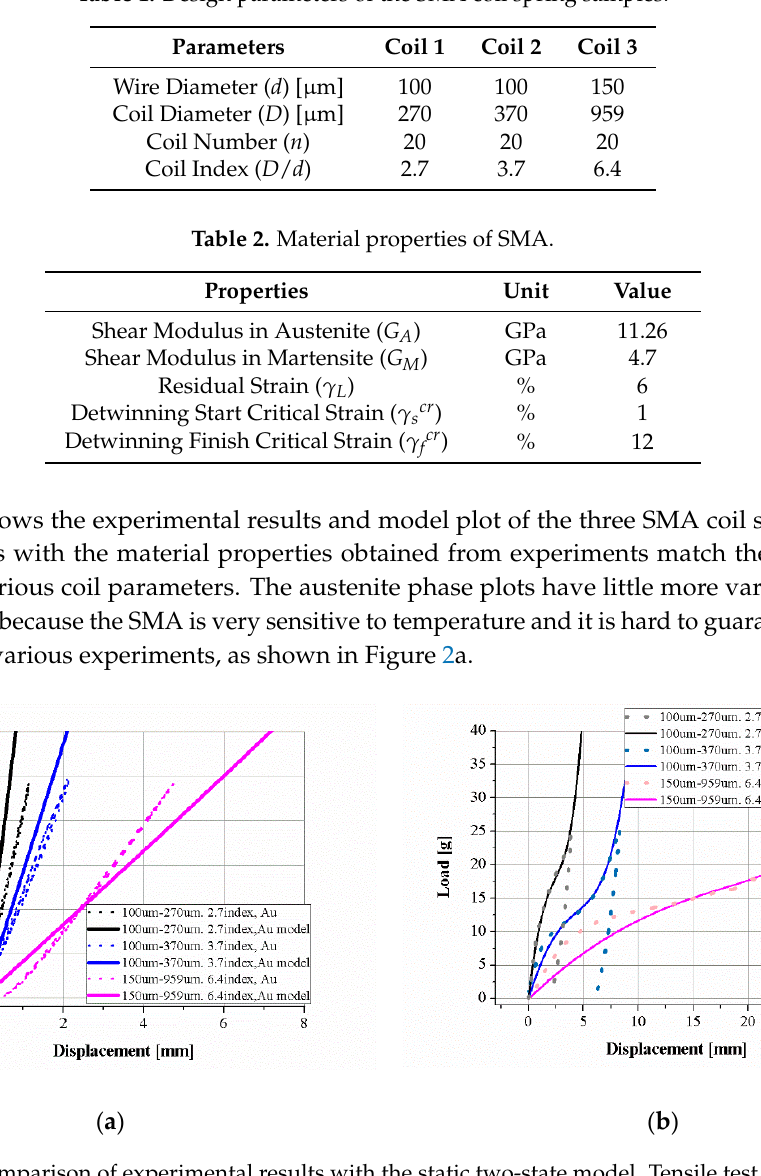
Table 1. Design parameters of the SMA coil spring samples.